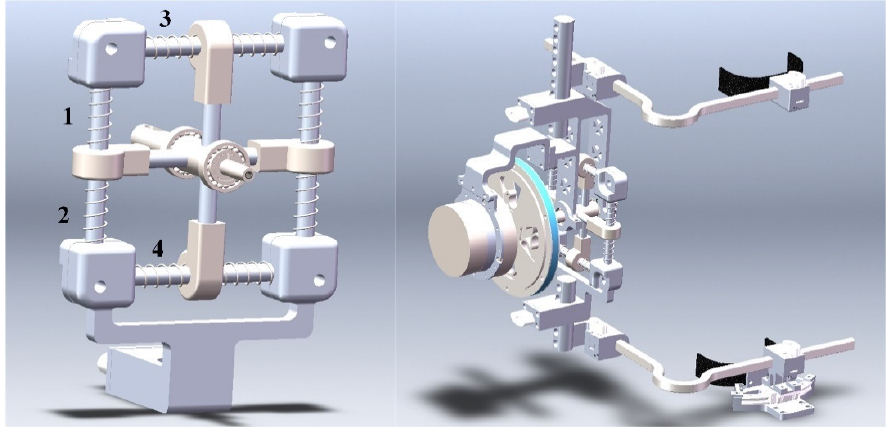
Figure 3. CAD model of the knee joint.